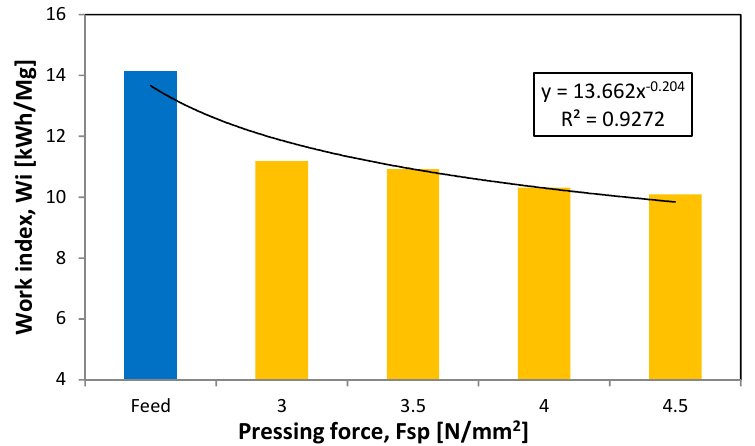
Figure 4. Values of Bond’s work indices obtained for HRC products in various pressing force values.